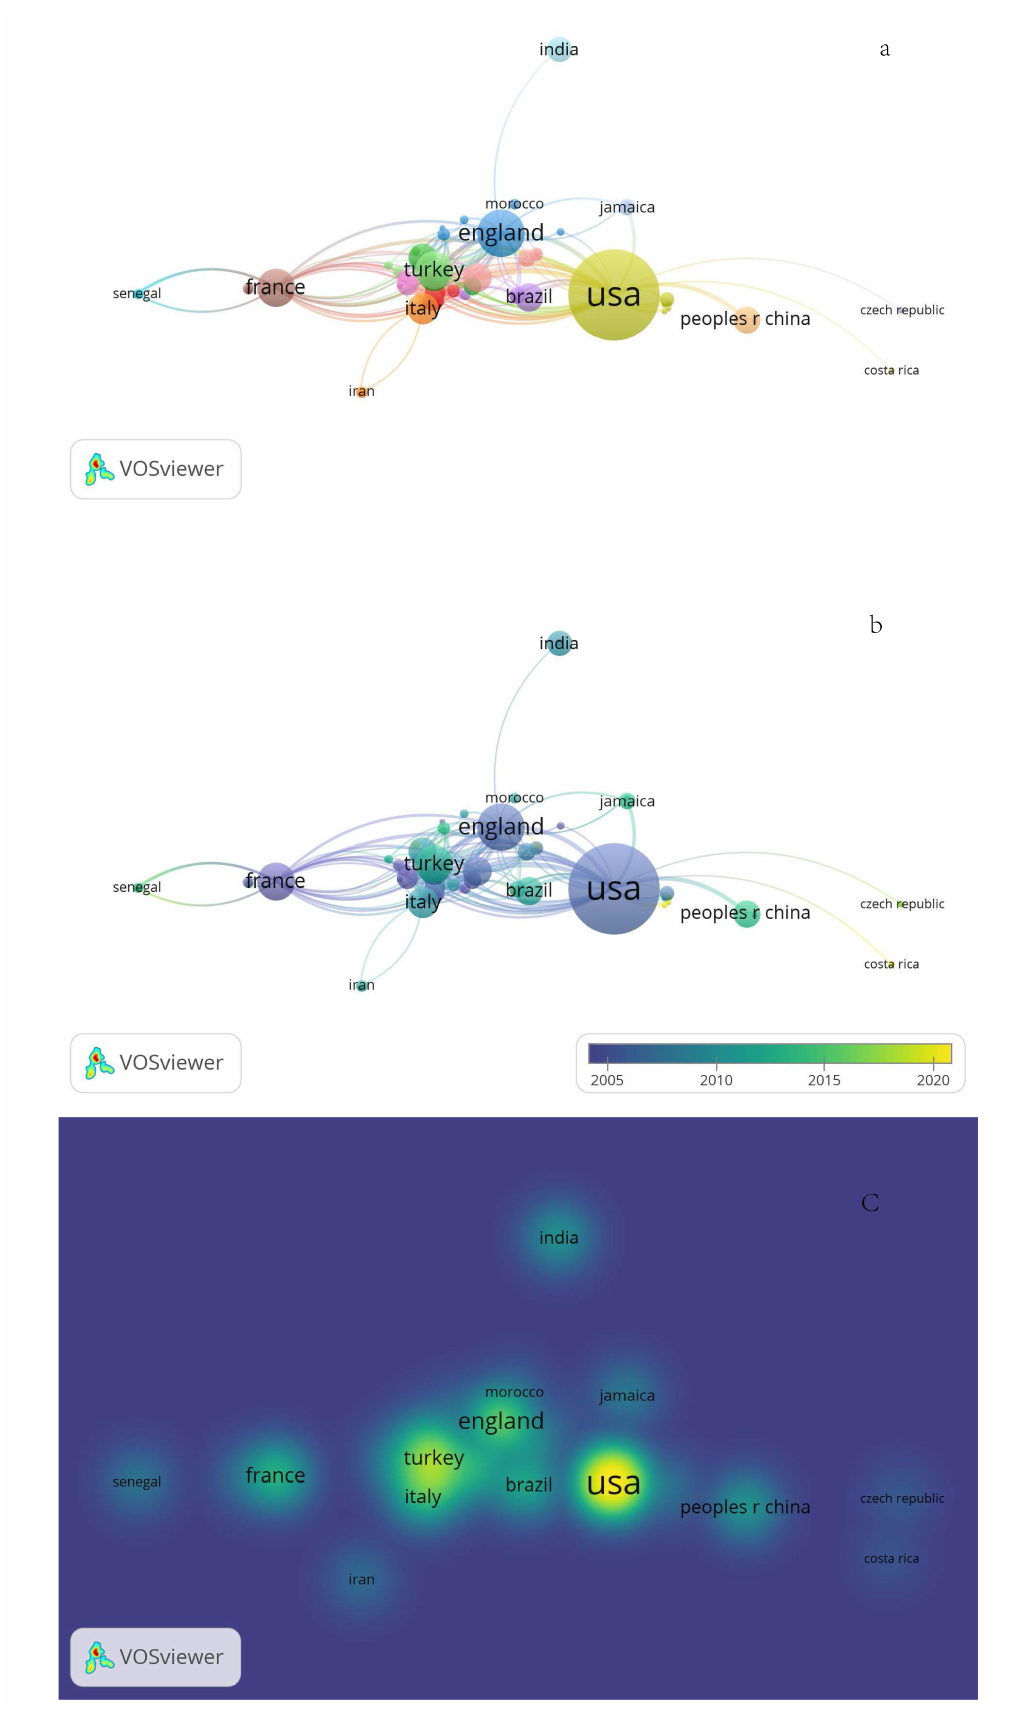
FIGURE 2. The font size of each country represents the number of articles in the country. The thickness of the lines indicates the strength of the connection. a, the country collaboration network of research on priapism. b, different colors inside the circle represent different time intervals. c, the brighter the color, the more publications for